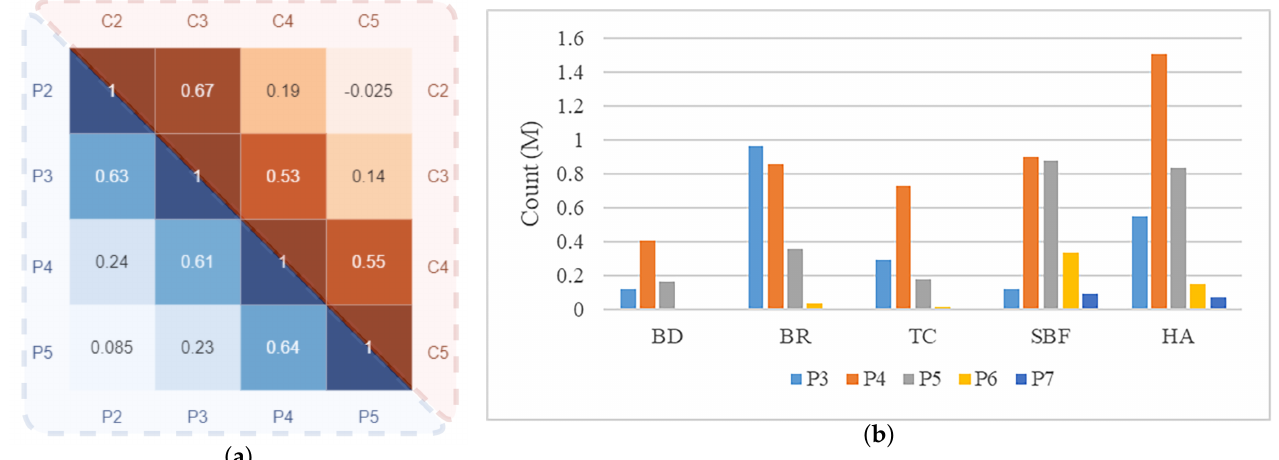
Figure 5. ( a ) Correlation matrix of different layers. The blue in the lower left corner and the red in the upper right corner are the correlations of the backbone features and pyramid features, respectively. ( b ) Pyramid-level distribution of different categories predicted by baseline. The colors of the columns represent different pyramid levels, and the categories include baseball diamond (BD), bridge (BR), tennis count (TC), soccer field (SBF), and harbors